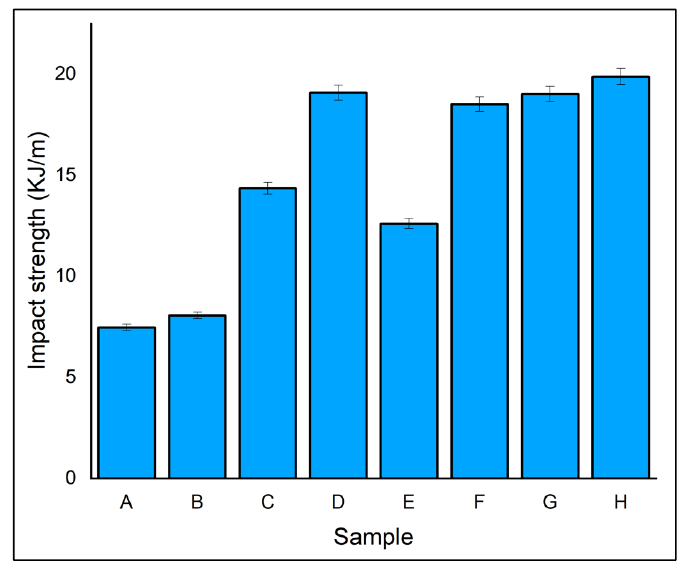
Figure 11. Impact strength of specimen.